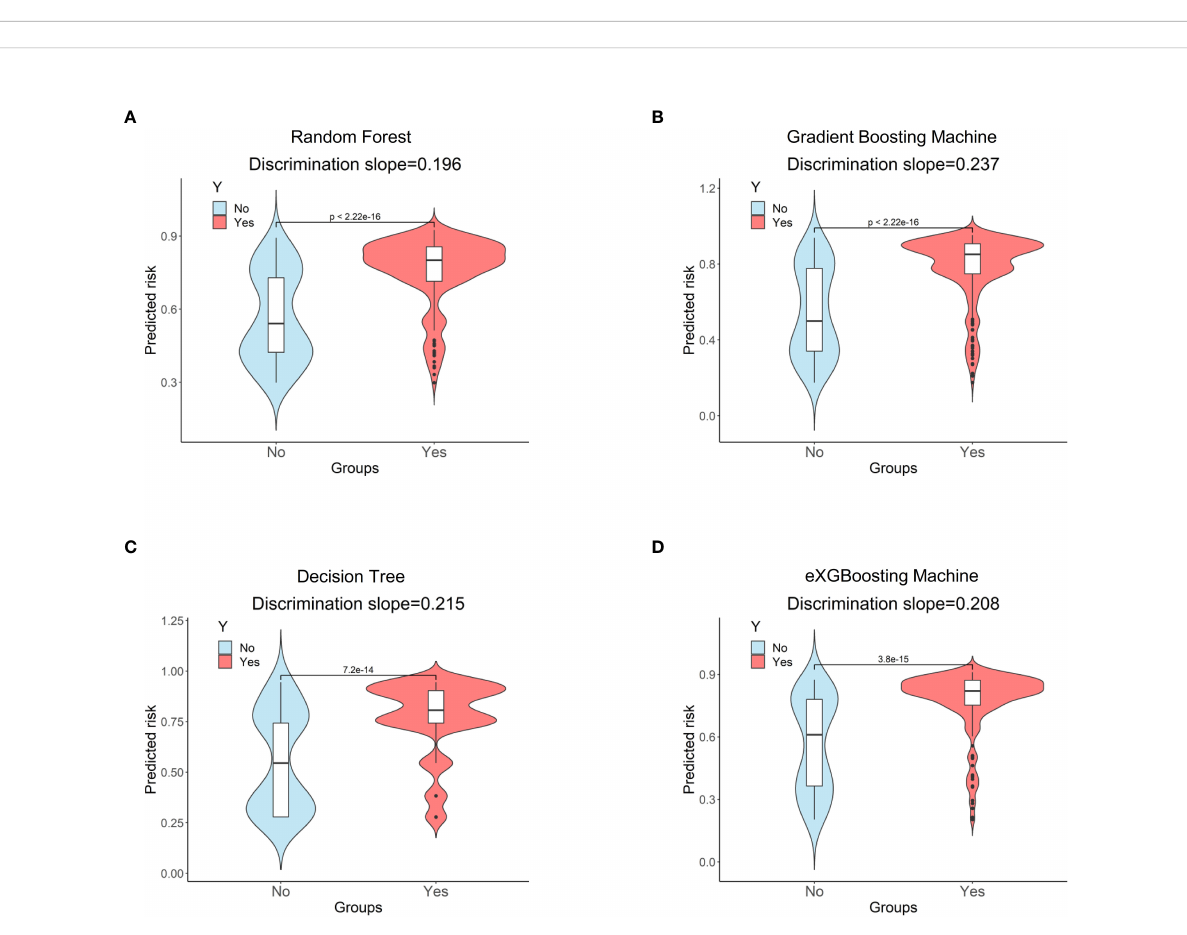
FIGURE 5 Discrimination slopes for each approach. (A) Random Forest; (B) Gradient Boosting Machine; (C) Decision Tree; (D) eXGBoosting